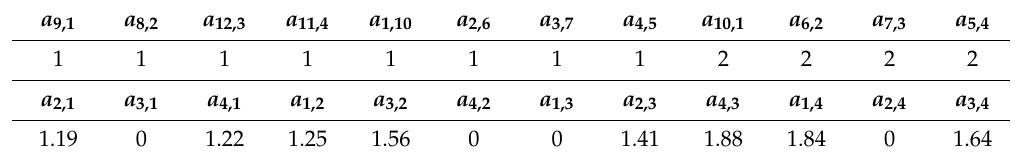
Table 3. The connection weight of neuronal axons in the network.